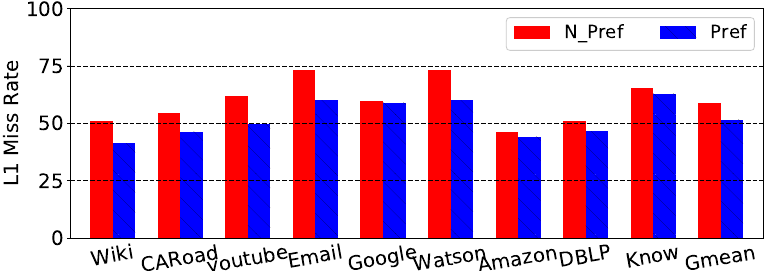
Figure 6. L1 miss rate graph traversal benchmarks without prefetch ( N_Pref ) and with stream prefetch ( Pref ).